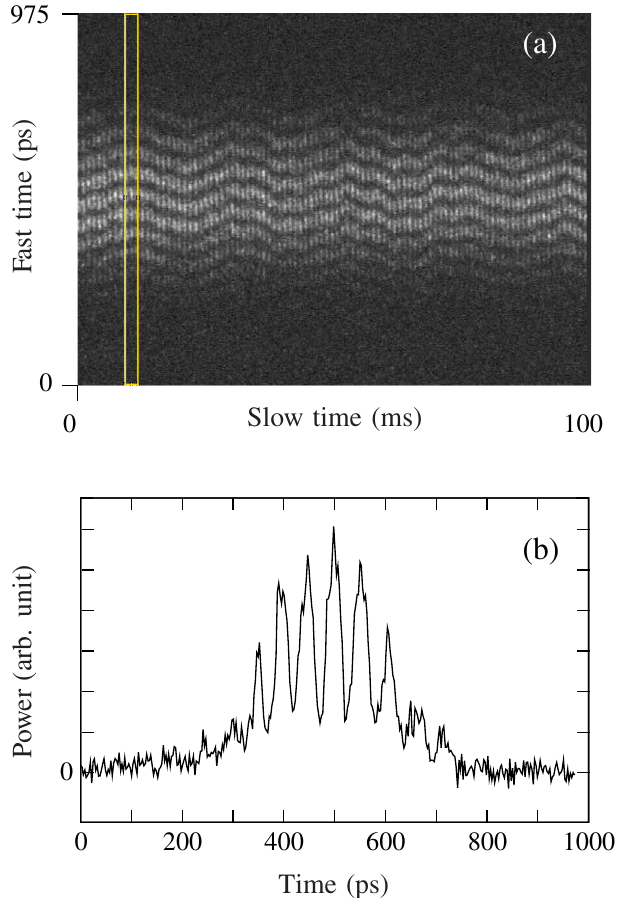
FIG. 3. (Color) Pulse shape, checked at very low modulation wave number, using a double sweep streak camera. (a) Raw streak camera image, where 100 successive pulses are recorded. (b) Pulse shape averaged over 3 ms, i.e., the rectangular area 60 Hz), with an amplitude of several hundreds of